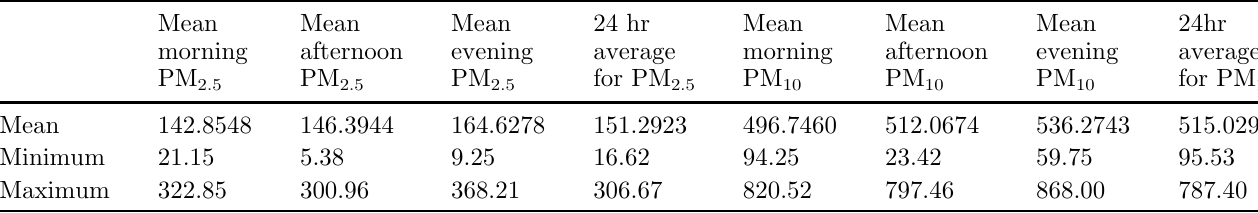
Table 5. Concentration levels of particulate matters during the dry season.